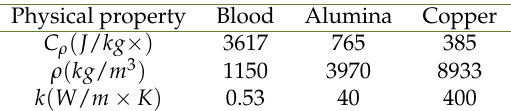
Table 1. Thermophysical properties of the fluid Physical property Blood Alumina Copper